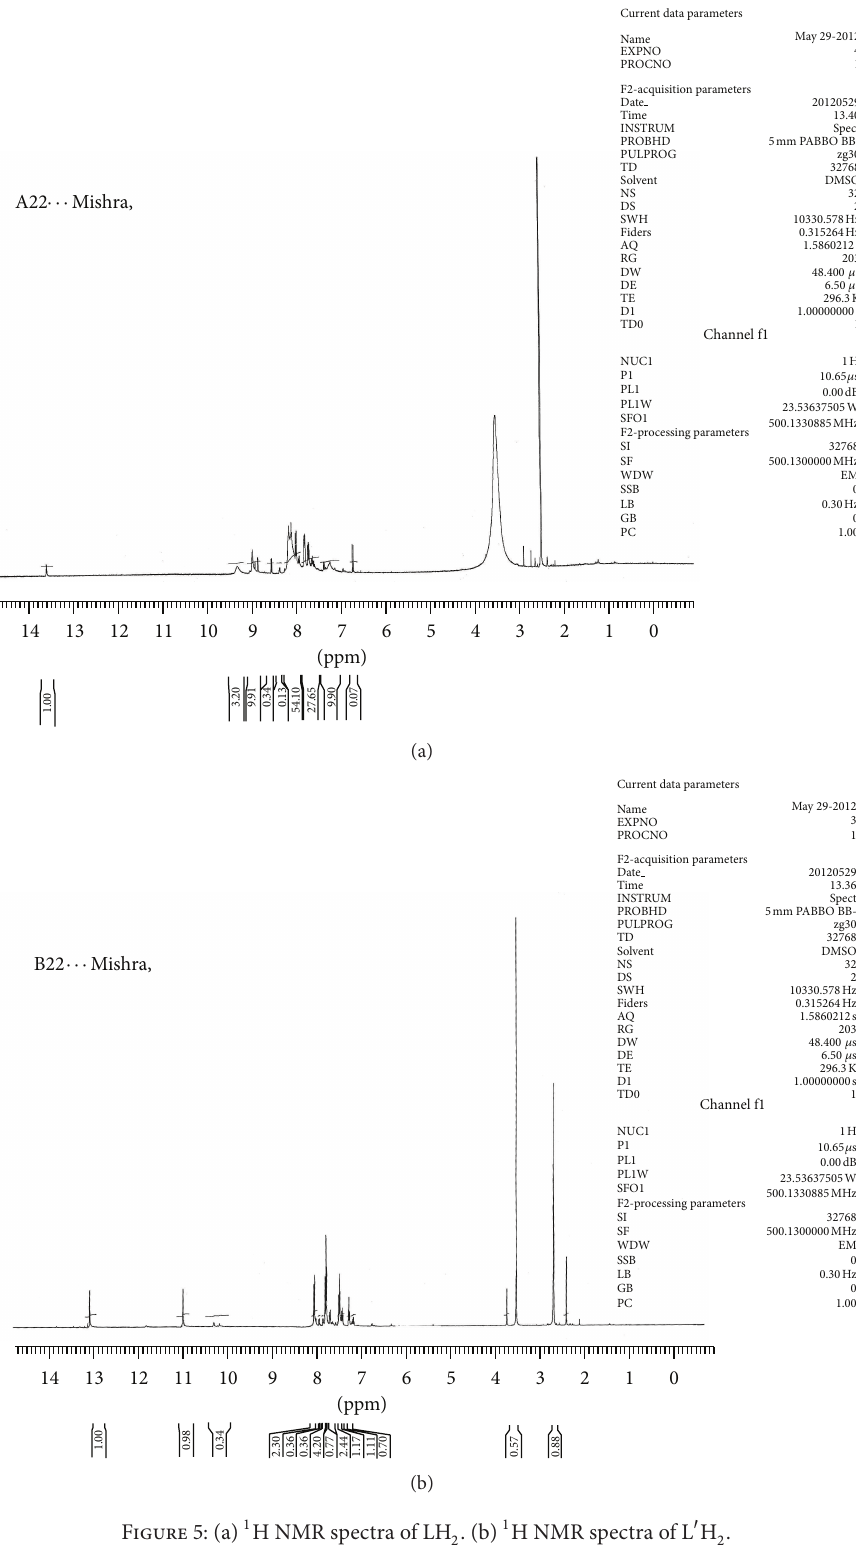
Figure 5: (a) 1 H NMR spectra of LH 2 . (b) 1 H NMR spectra of L 󸀠 H 2